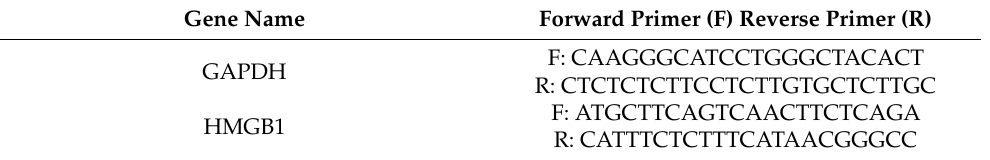
Table 1. Primer sequences.